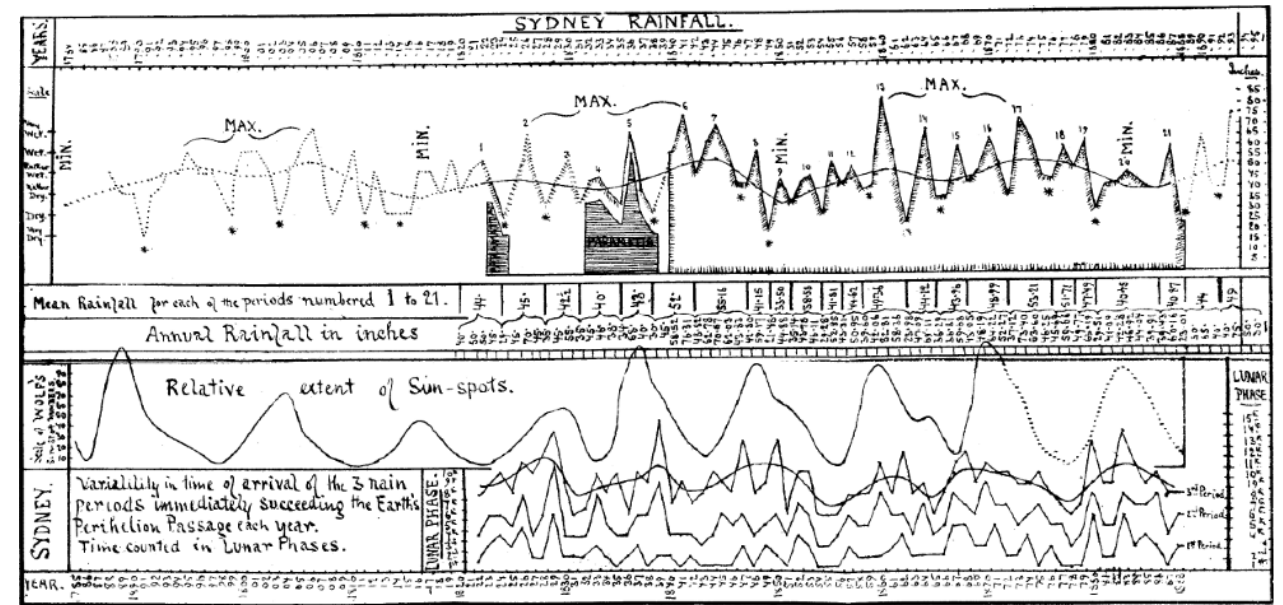
Figure 1b. Rainfall (top) and relative extent of sunspots published by Egeson (1889). His three maxima and the prior publications may have prompted him to refer to a 33-year cycle, a courageous extrapolation at best, but one validated by a subsequent cosinor analysis, Fig. 5; the point estimate of the period happens to be around 33 years in a global analysis of the time series as a whole (rainfall was also a major variable studied by Eduard